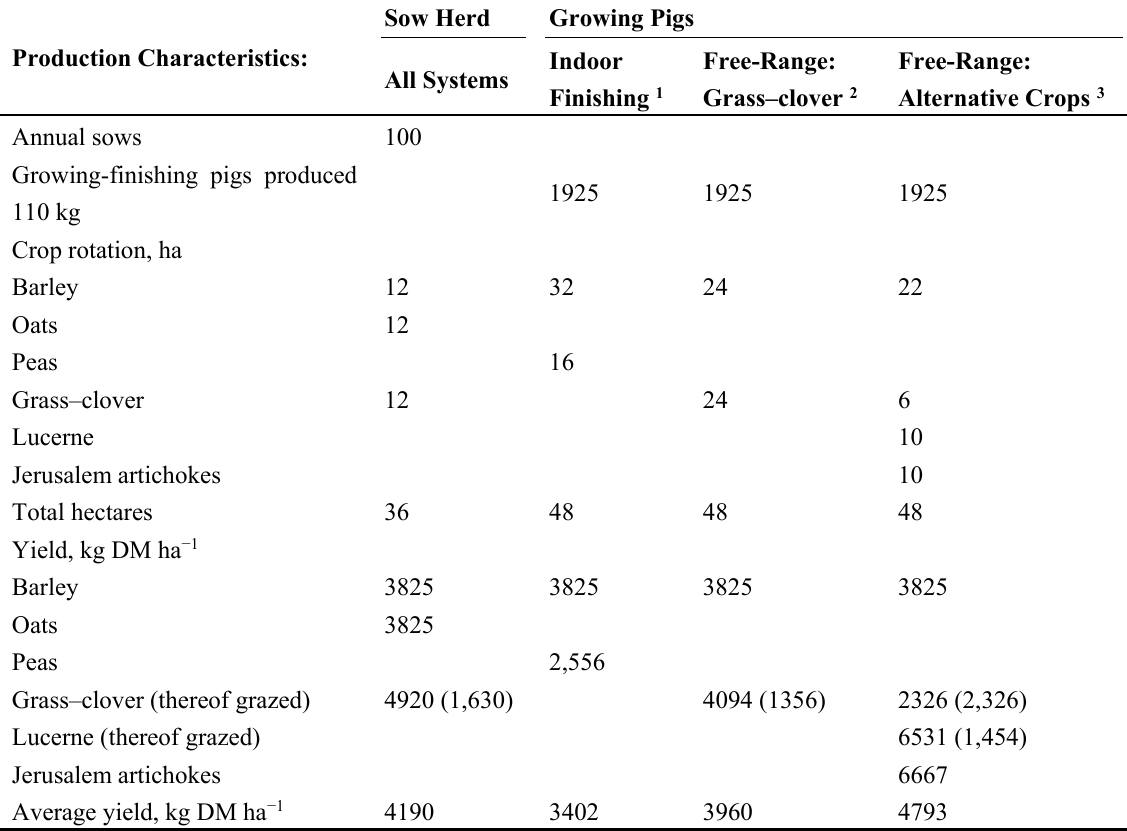
Table 1. Production characteristics for three organic pig production